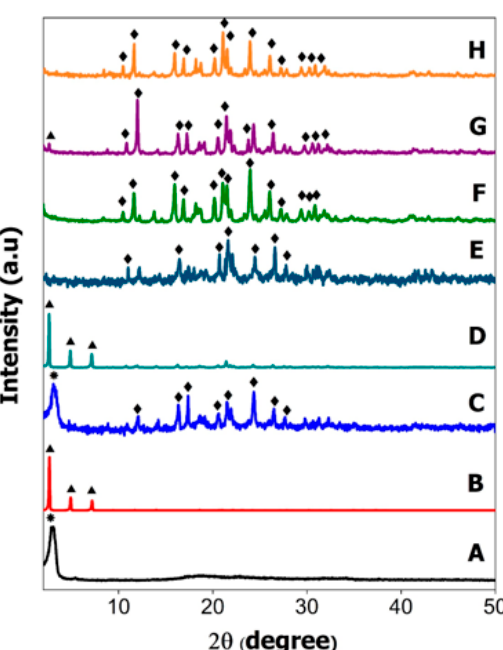
Figure 2. XRD patterns of pure SDBS ( A ), SDS ( B ), physical mixture of HMBS ( C ), HMDS ( D ), HMT ( E ), and their hexaconazole-micelle nanodelivery systems; HMBS ( F ), HMDS ( G ) and HMT ( H ).